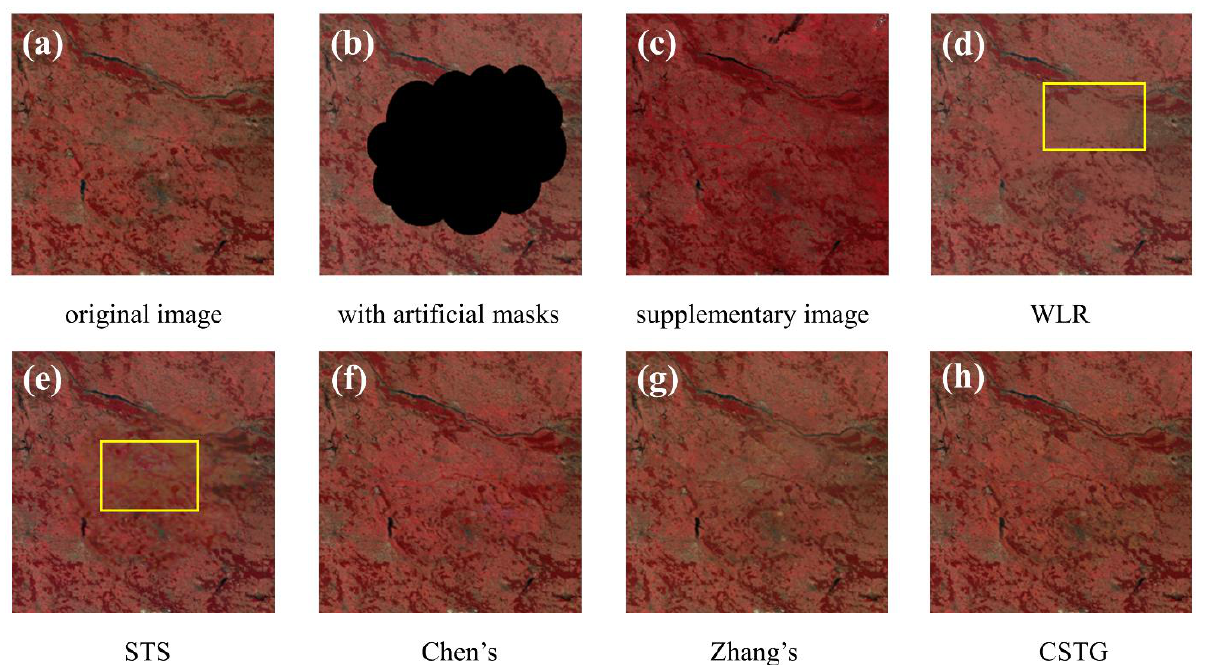
Figure 6. Comparisons of the observed images and the gap-filled images when applying a large and intensive mask are shown for ( a ) the original image acquired on 26 February 2019, ( b ) the image with artificial masks, ( c ) the supplementary image acquired on 29 August 2019, and the images recovered by ( d ) WLR, ( e ) STS, ( f ) Chen’s method, ( g ) Zhang’s method, and ( h )